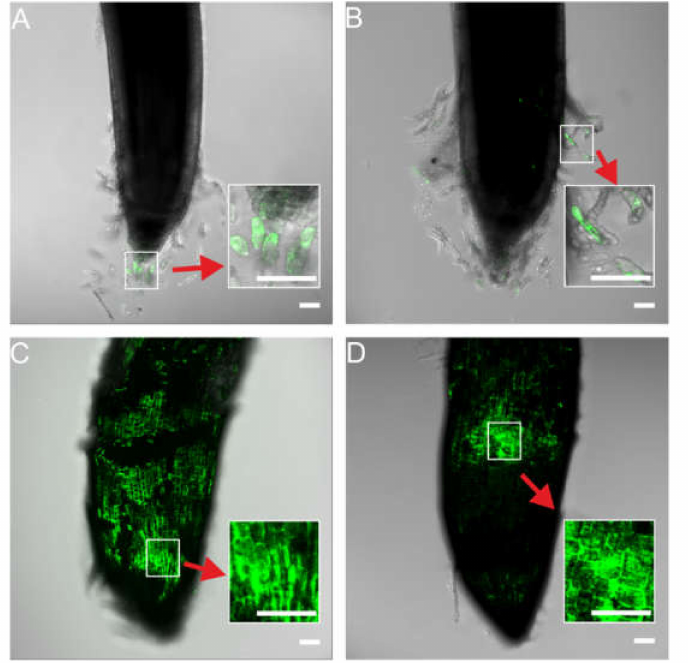
Figure 4. Determination of cellular ROS by H 2 DCF-DA assay ( A – D ) in the wheat root tips after 3 days of seedling development in (Bio)Ag NPs at 0 ( A ), 10 ( B ), 20 ( C ), and 40 ( D ) mg/L. Scale: the length of the horizontal white bars equals 100 µ m.